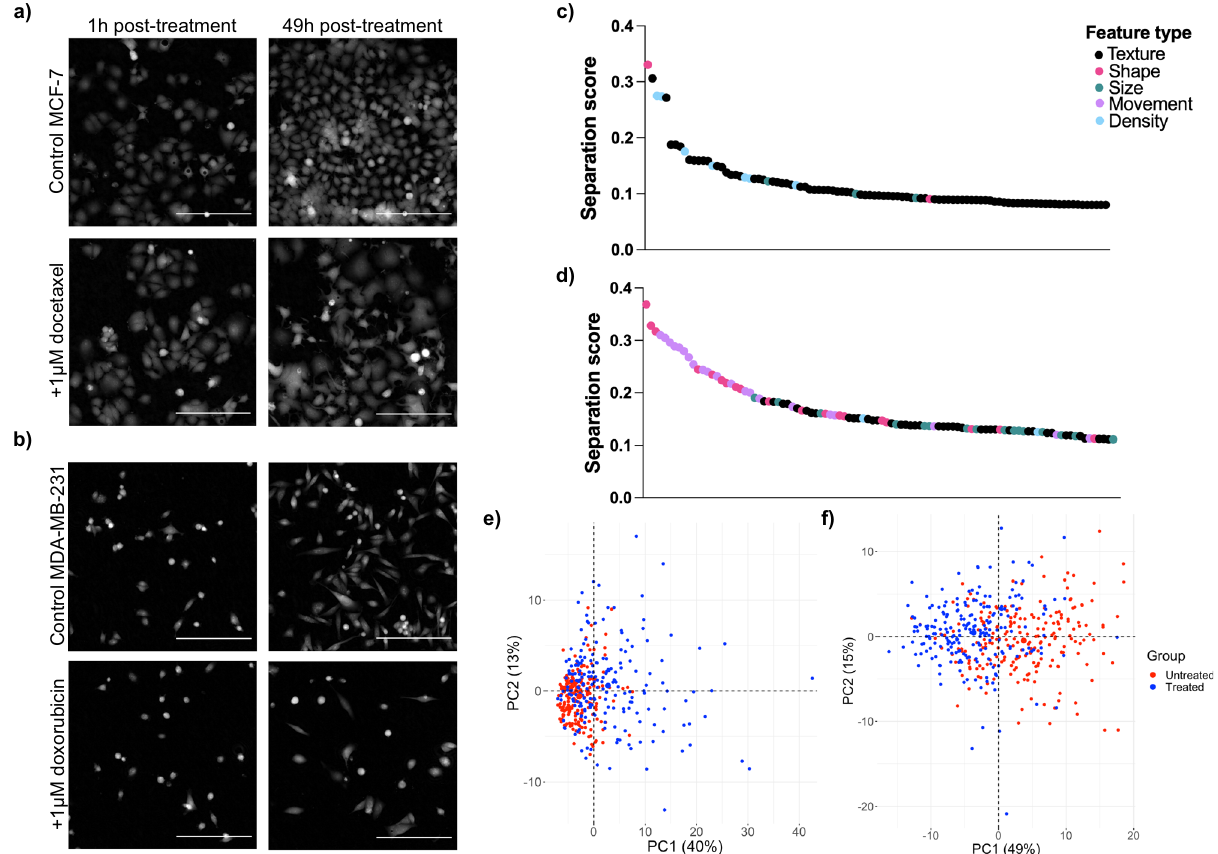
Fig. 4 | Discrimination between treated and untreated cells for MCF-7 with docetaxel and MDA-MB-231 with doxorubicin. Images taken from cell time- lapses of a untreated and 1 μ M docetaxel treated MCF-7 cells and b untreated and 1 μ MdoxorubicintreatedMDA-MB-231cells.Scalebar=200 μ m.Differencesincell countfollowingtreatmentcanbeobservedforbothduetocellcyclearrestinduced by docetaxel or doxorubicin respectively. Docetaxel treated MCF-7 cells display enlarged cell phenotype at the 49h time point due to failed cytokinesis. In com- parison, differences in morphology are more subtle for doxorubicin treated MDA-